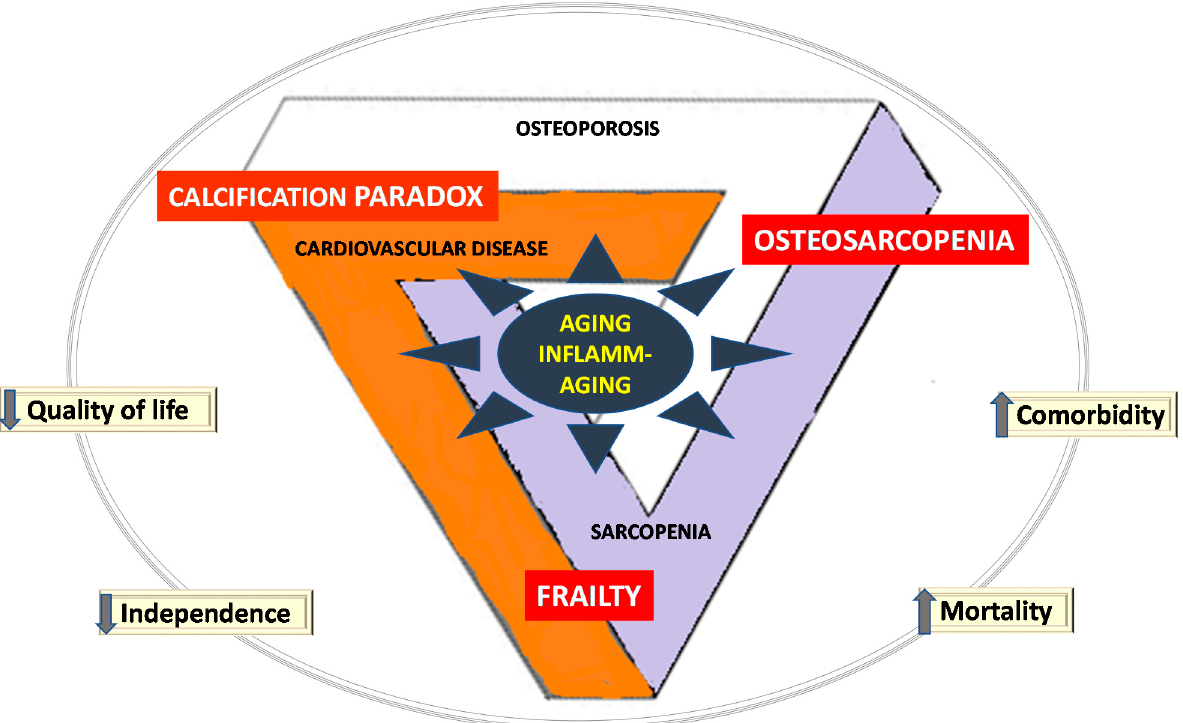
Figure 1. Interactions and issues in the cardiovascular-muscle-bone triad. Concepts have emerged in aging, with inflamm- aging [20] at the root of the development of age-related chronic diseases. Aging patients may develop osteosarcopenia [21], a combination of osteoporosis and sarcopenia; they may develop diminished calcification in osteoporosis with increased arterial calcification, namely the calcification paradox [22]; they may also develop frailty, sarcopenia, and cardiovascular disease [23]. These interactions participate in diminishing (down arrows) quality of life and independence and increasing (up arrows) comorbidity and mortality in aging persons [1].